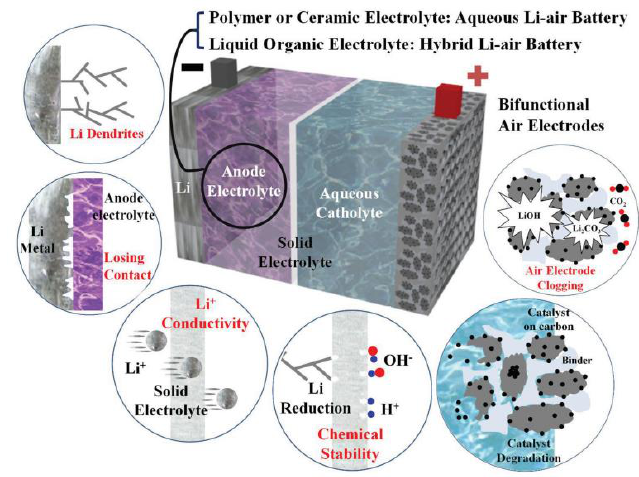
Figure 19. Schematic of hybrid and aqueous Li-air batteries. The anode electrolyte can be a conventional polymeric separator soaked with an organic electrolyte or a polymer or ceramic Li + -ion solid electrolyte, as indicated. Republished from Manthiram and Li [27] with permission of John Wiley and Sons conveyed through Copyright Clearance Center, Inc.